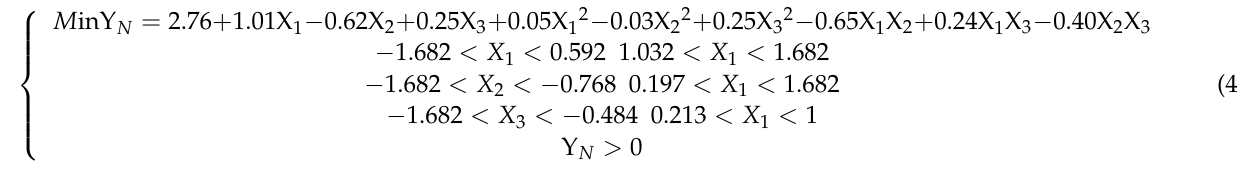
Table 4. The frequency distribution of ridge height, row grade, and field slope at 95% confidential interval for NO 3 − –N and PO 4+3 –P losses greater than the